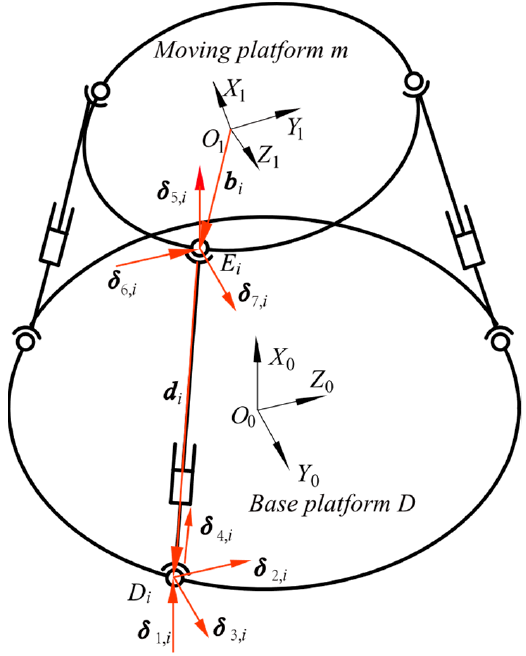
Figure 4. The vector representation of the SPS limbs.